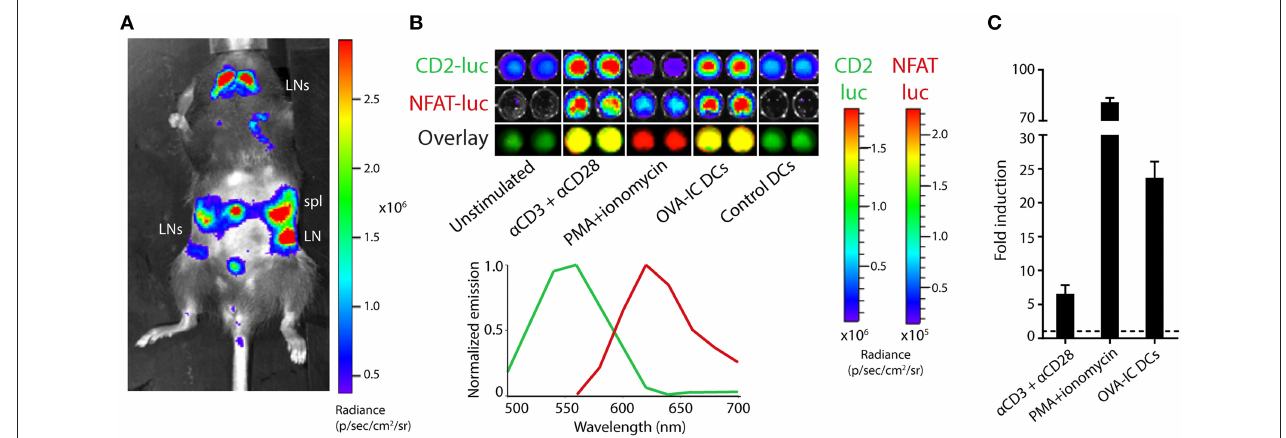
FIGURE 3 | Dual-luciferase imaging of antigen-specific T cells. (A) Bioluminescence measurement of a TbiLuc*OT-I mouse, showing luciferase expression in secondary lymphoid organs. The abdomen is shaved to reduce signal absorption. The spleen (spl) and various lymph nodes (LN) are indicated. (B) CD8T cells were isolated from the spleen of TbiLuc*OT-I mice and stimulated overnight with agonistic CD3/CD28 antibodies, PMA + ionomycin, dendritic cells loaded with OVA protein immune complexes (OVA-IC DCs) or with unloaded control DCs, as indicated. Subsequent bioluminescence imaging shows constitutive CBG99 expression (CD2-luc, top), activation-induced PpyRE9 expression (NFAT-luc, middle) and an overlay of artificial green and red colors (bottom) corresponding to the spectral unmixing as shown in the bottom-right graph. Representative data from two independent experiments. (C) Fold induction of NFAT-luciferase expression in TbiLuc*OT-I cells after stimulation with PMA + ionomycin or α CD3 + α CD28 compared to unstimulated cells, or after incubation with OVA-IC DCs compared to control DCs. Signals are corrected for differences in constitutive hCD2-luciferase expression. Baseline expression (1-fold) is indicated by the dotted line. Representative data of two independent experiments with n = 2 samples per group each. Mean +